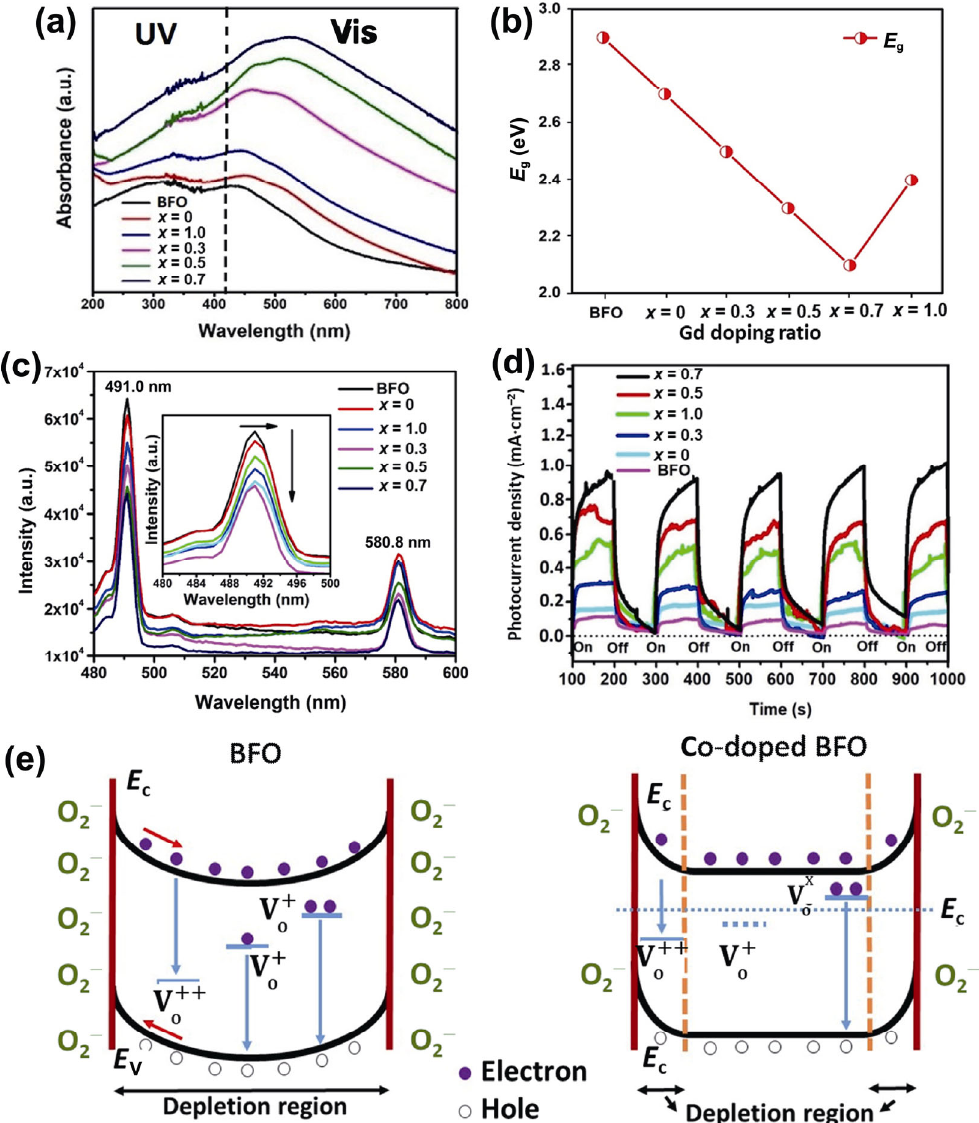
Fig. 3 Effect of introduced OVs in BFO on the band structure and optical properties: (a) UV–Vis absorbance spectra in the wavelength range of 200–800 nm, (b) relationship between E g and Gd doping ratio, (c) PL spectra with the magnified spectra inset, (d) transient photocurrent response with light on/off cycles of 100 s, and (e) schematic illustration of the charge trapping mode of OVs in BFO and co-doped BFO